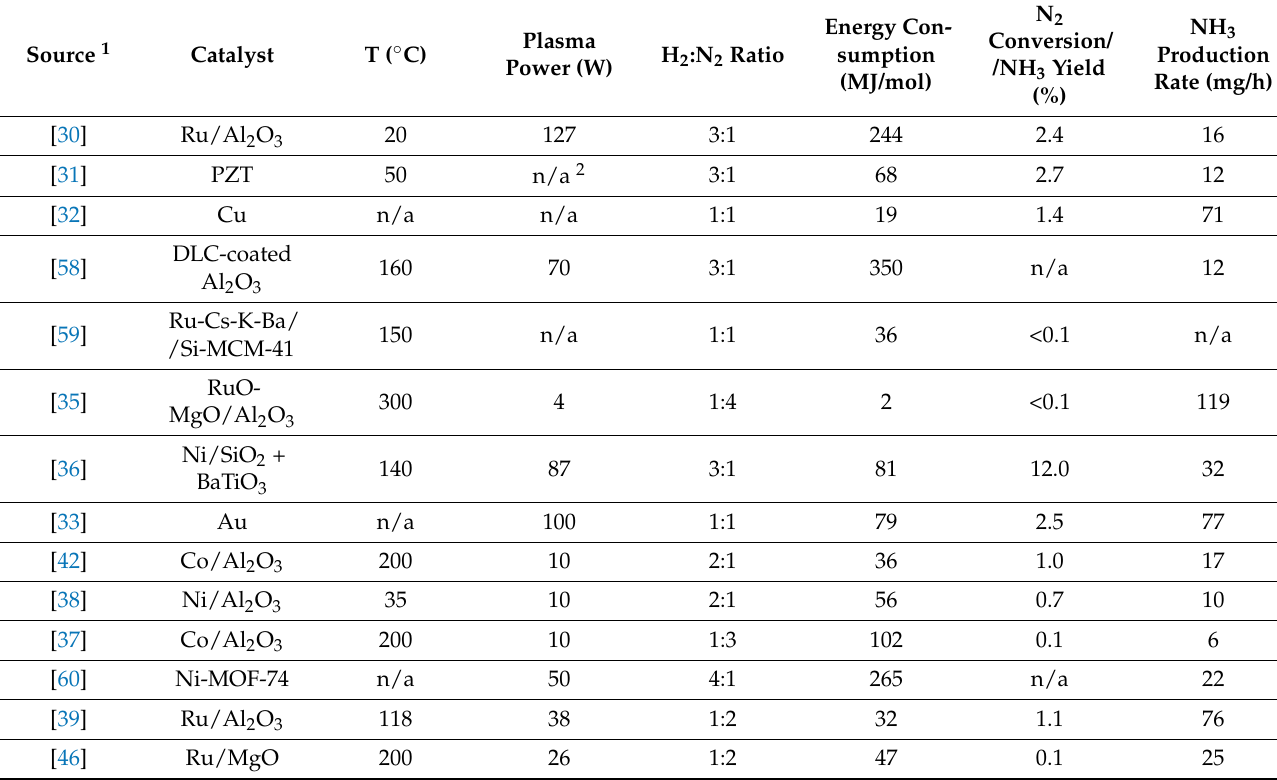
Table 4. Summary of studies on NH 3 production from N 2 and H 2 in DBD plasma reactors, as well as comparison with our work.